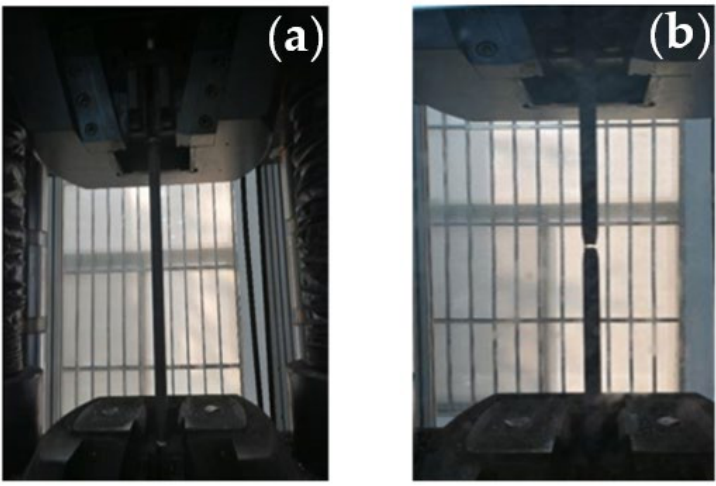
Figure 2. Start and end of tensile test. ( a ) Start of tensile text. ( b ) End of tensile test. Before the anchor bolt was loaded, the anchor bolt was pretensioned 1–2 times by applying a load that was 0.1–0.2 times that of the design value, so that the anchor bolt